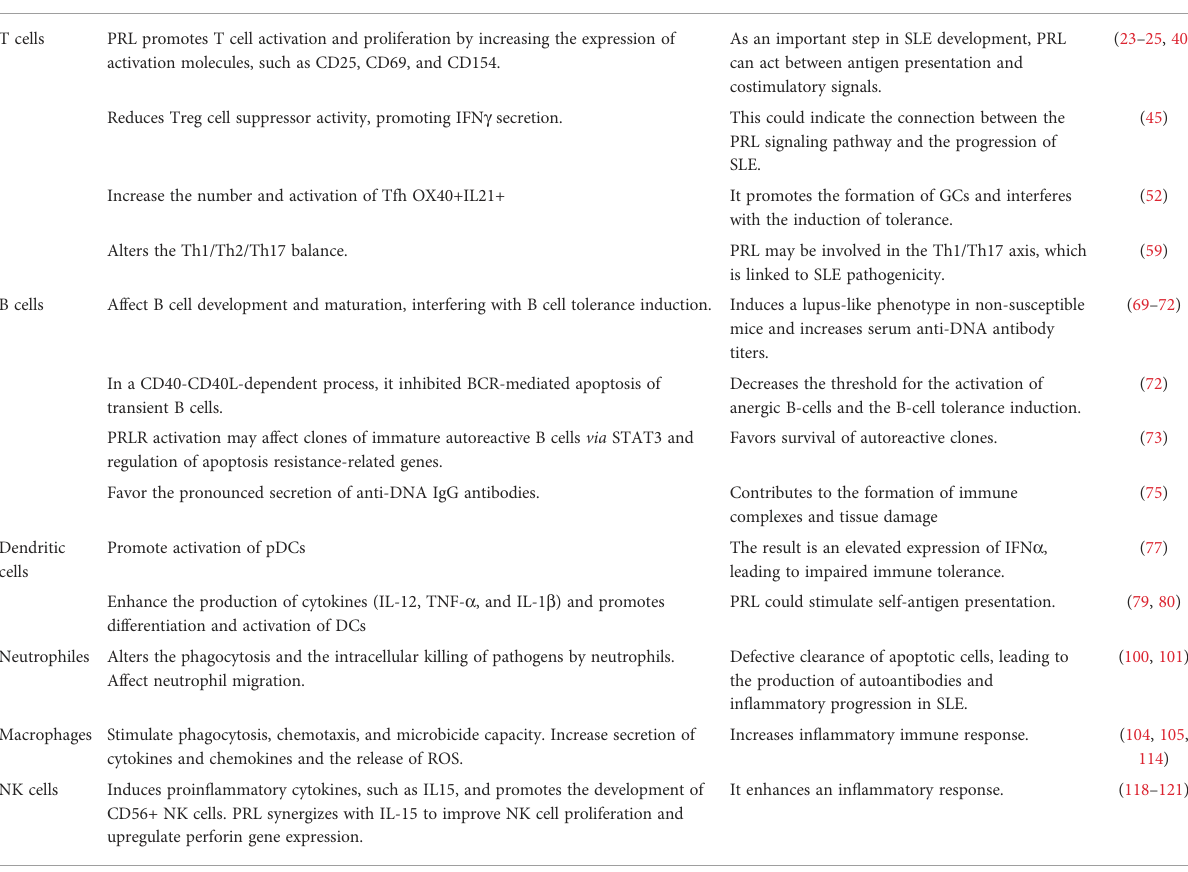
TABLE 1 Effects of PRL on immune system cells in